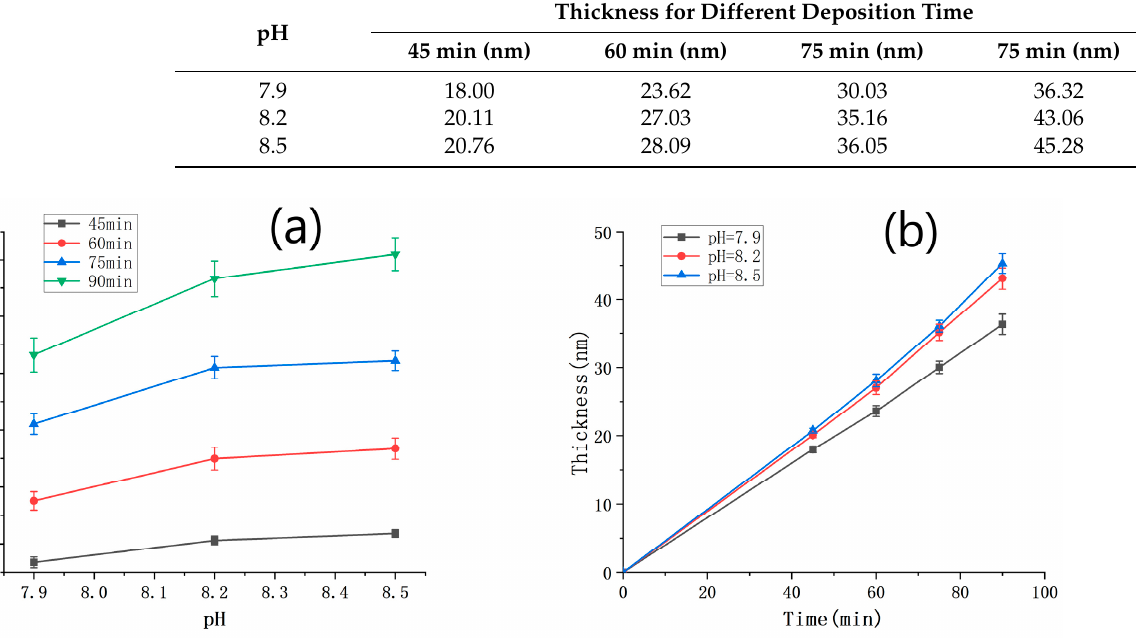
Table 1. Thickness of the PDA fi lm deposited for di ff erent time. Figure 3. ( a ) PDA film thickness against pH under different time conditions; ( b ) PDA film thickness Figure 3. ( a ) PDA fi lm thickness against pH under di ff erent time conditions; ( b ) PDA fi lm thickness against deposition time under different pH against deposition time under di ff erent pH conditions.